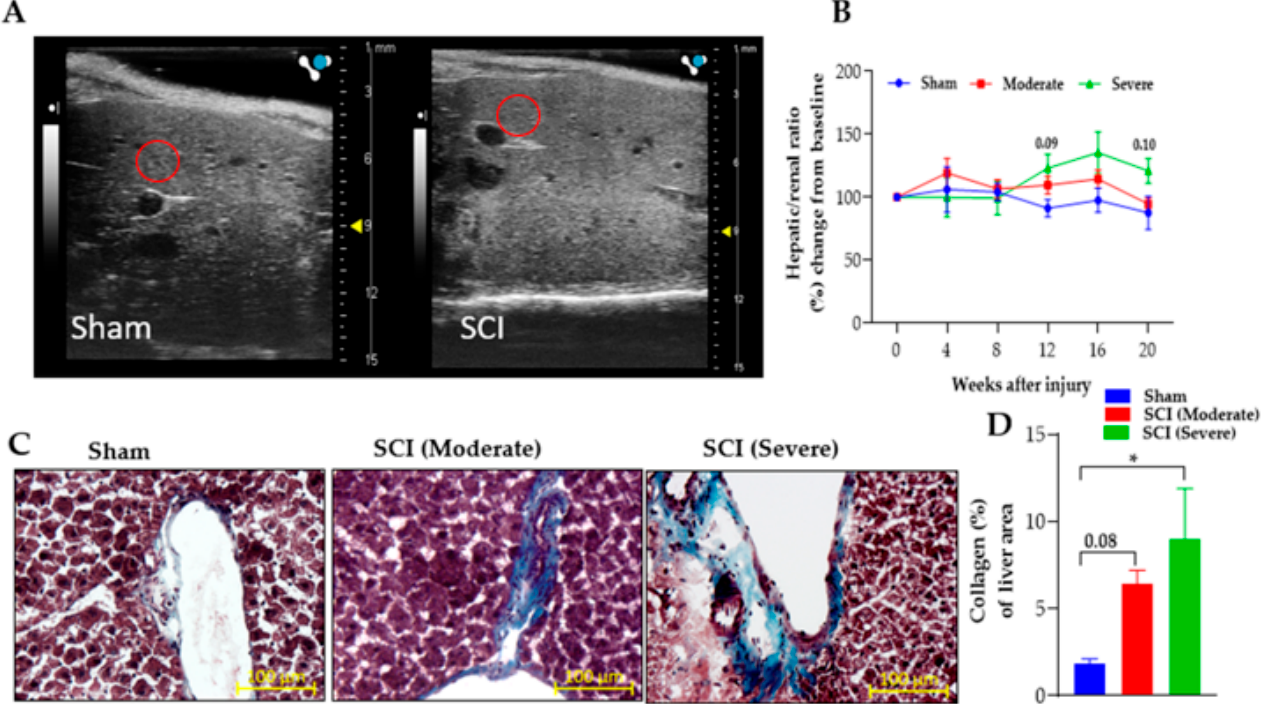
Figure 4. Injury-severity dependent reduction in liver function. SCI induced liver intensity and fibrosis. ( A ) Representative images of liver show echogenicity of the liver parenchyma increased in the severe group compared to sham group using ultrasound imaging at 20 weeks PI of sham and severe SCI. Red circles located on the liver images represent areas of interest that were quantified. ( B ) Severe SCI increased liver intensity after 12 weeks PI compared to sham group. Kidney tissue was used as the internal control with data represented as a ratio of hepatic/renal percent change from baseline measurements. ( C ) Representative liver sections stained with Masson’s trichrome of sham, moderate-SCI, and severe-SCI at 20 weeks PI. ( D ) Quantification of collagen contents (blue) in the liver. SCI significantly increased fibrotic tissue in severe injured group and there is a trend towards an increase in the moderate group compared to the sham control. Scale bar = 100µm. Values presented as mean ± S.E.M of 3–4 sections/mouse; n = 6 (sham), 8 (moderate), and 5–9 (severe). Data analyzed by two-way ANOVA. Tukey’s multiple comparisons test was used to determine the differences between the groups; one-way ANOVA for D. * p ≤ 0.03, ** p ≤ 0.002, *** p ≤ 0.001.